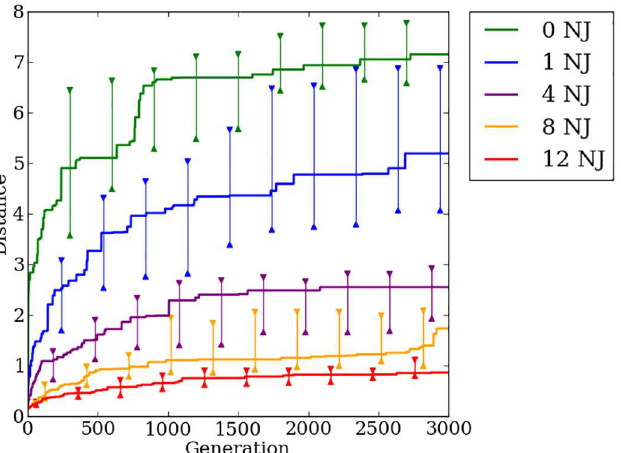
Fig 28. The median distance traveled by the transferred Auto-Offset-HybrID population generation champions over 3,000 generations on the quadruped robot transfer experiment. The line colors indicate the numberof noisy joints on the robot. 95% bootstrapped confidenceintervals of the median are shown every 300 generations.